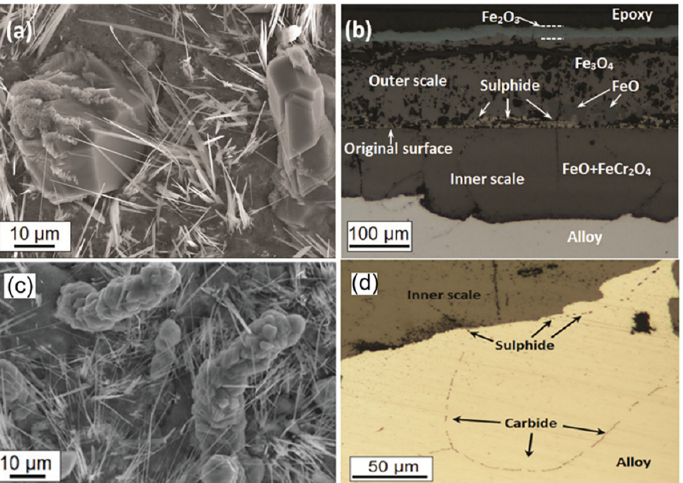
Figure 14. SEM surface morphology ( a ) and cross-section ( b ) images of Fe9Cr alloy exposed to Ar-20%CO 2 -0.5%SO 2 gas for 500 h at 650 °C/1 bar. Surface morphology ( c ) and cross-section images after etching ( d ) of Fe20Cr alloy exposed to Ar-20%CO 2 -0.5%SO 2 gas for 500 h at 650 °C/1 bar [73]. Reproduced with permission from Springer Nature.